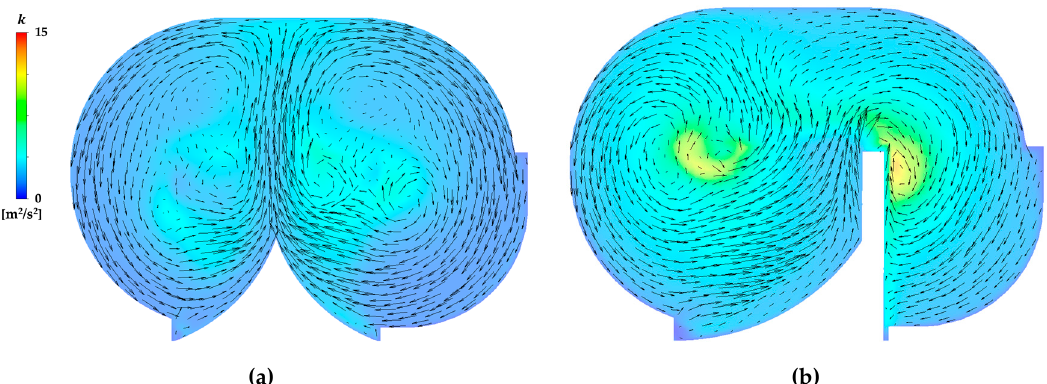
Figure 16. Velocity contours and vectors on Plane 2: ( a ) reference pump; ( b ) optimized pump.